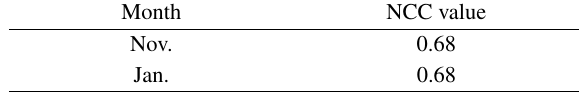
Table 12 NCC value between combined English and Arabic tweets (classified as self) and count of actual hospital